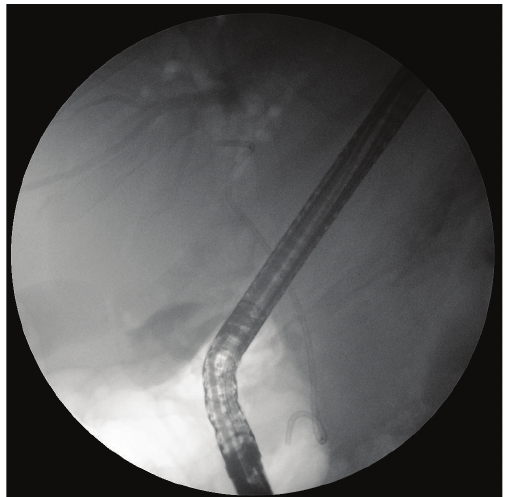
Figure 6: Double pigtail biliary stent within the CBD after basket